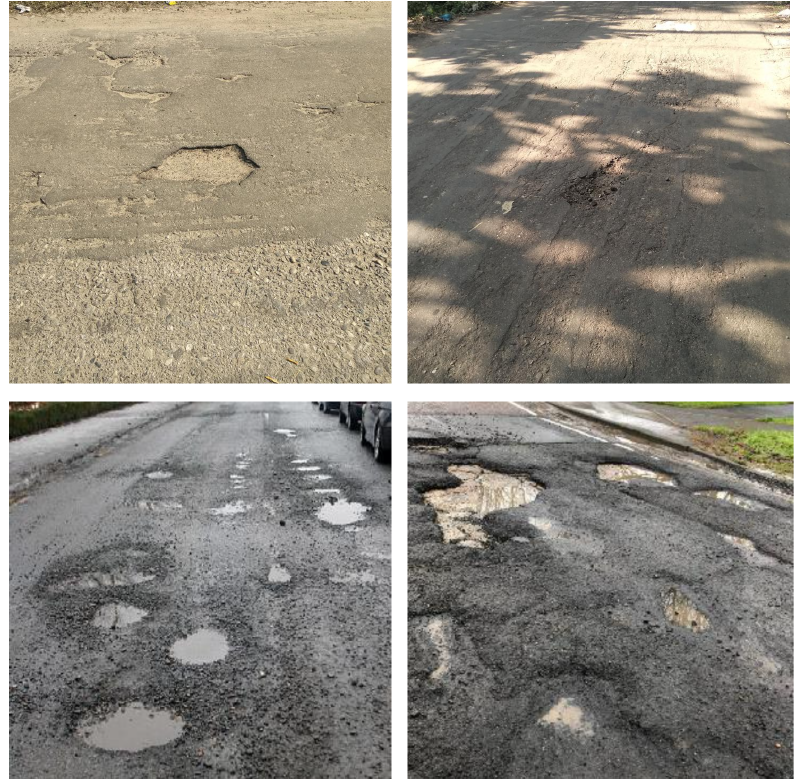
Figure 1. Potholes with different environments, shapes, and sizes in the self-made dataset. The upper left is a small round pothole in the normal environment. On the upper right is a long strip of the small pothole in the shadow environment. At the bottom left is a small round pothole in rainy weather. At the lower right is a large irregular pothole in rainy